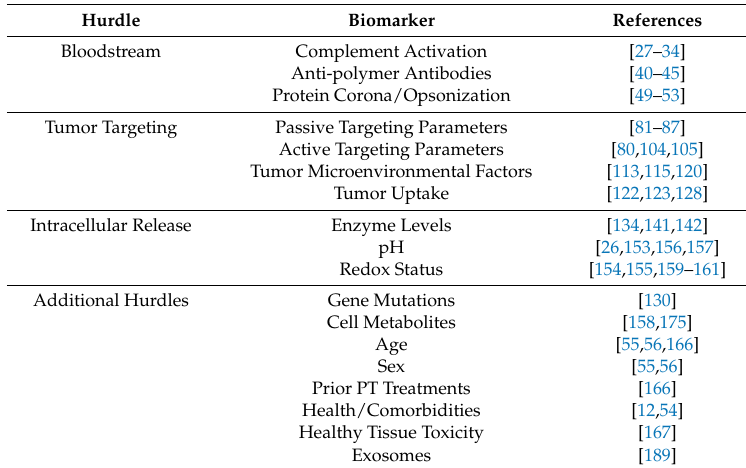
Table 1. A summary of Hurdles and Related Biomarkers.